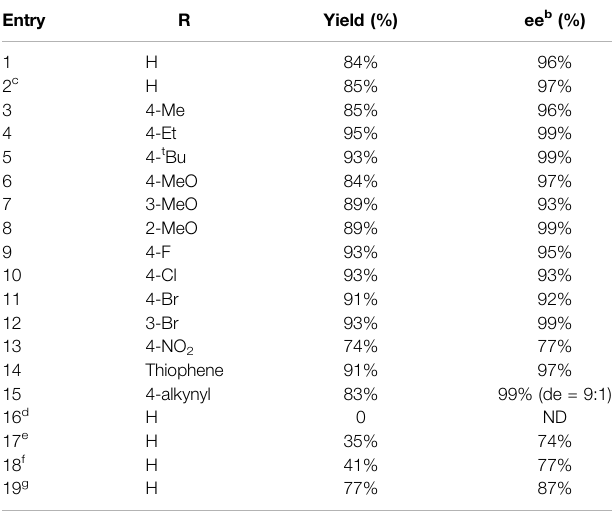
TABLE 1 | The Hydration – ATH one-pot enantioselective tandem reactions of alkynes into chiral alcohol.